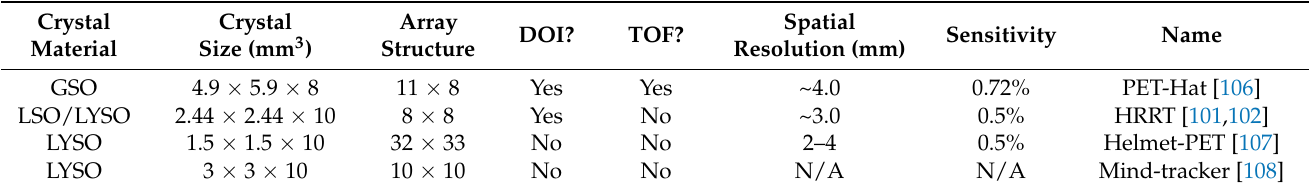
Table 4. Scintillation crystals used in brain-PET and their